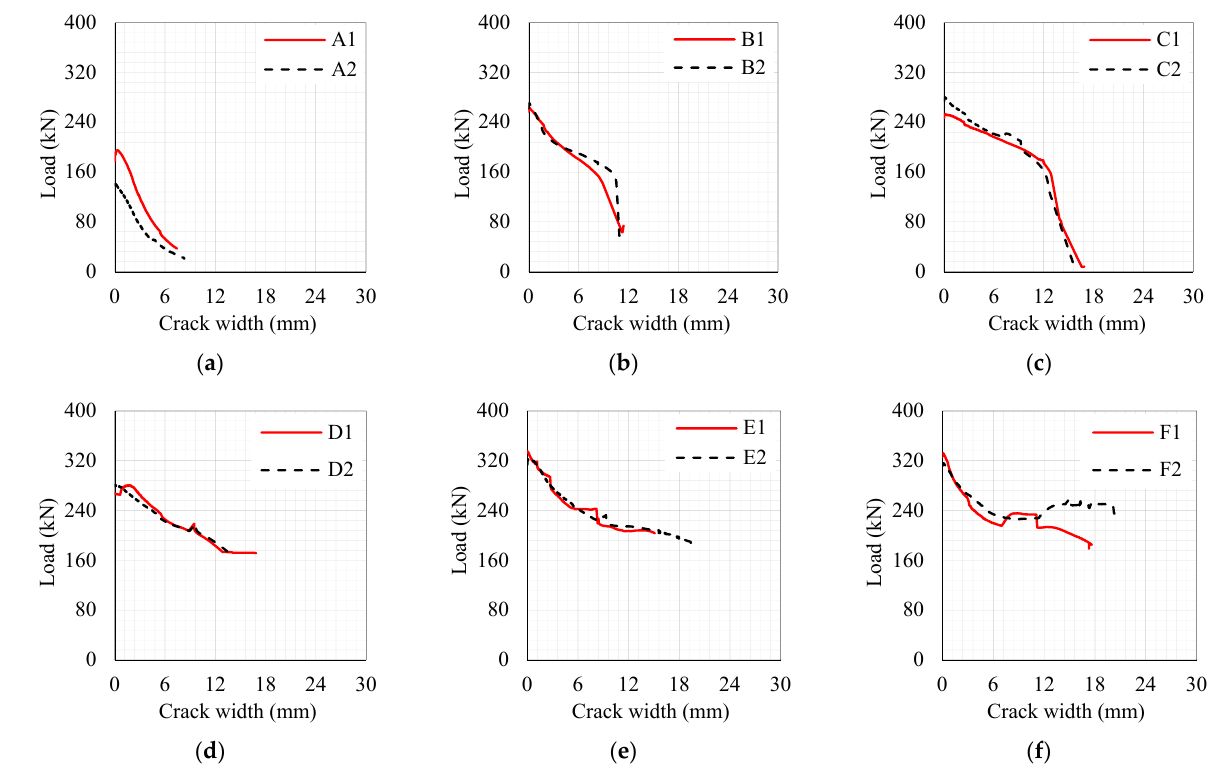
Figure 12. Load crack width responses for UHPC beams: ( a ) A, ( b ) B, ( c ) C, ( d ) D, ( e ) E, and ( f ) F.